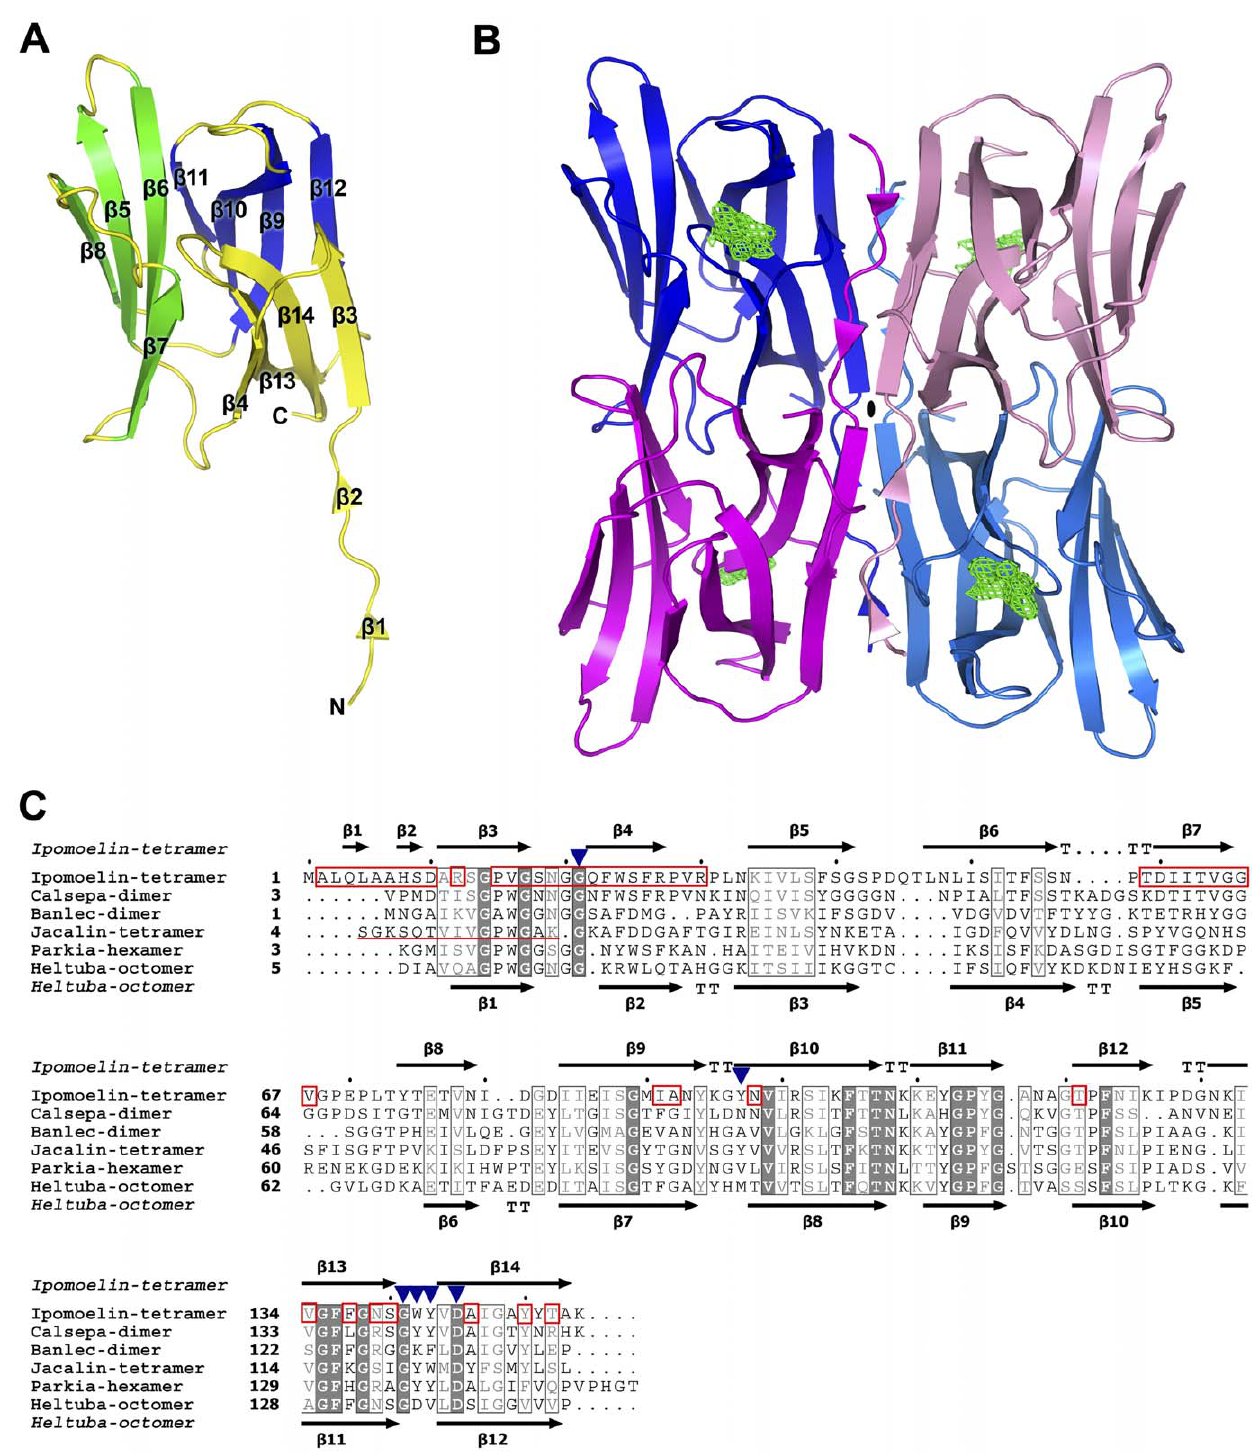
Figure 2. Ribbon diagram of IPO and sequence alignment of Jacalin-related lectins. ( A ) A ribbon diagram of monomeric IPO with 14 b - strands. ( B ) A ribbon diagram of a compact tetrameric IPO. The carbohydrate binding pockets are indicated by green mesh. Tetrameric IPO is represented by monomer A in blue, monomer B in purple, monomer C in light blue, and monomer D in pink. The symmetric axis is represented by a black ellipse in the center of tetramer. ( C ) Structure-based multiple sequence alignment of Jacalin family. Five homologs were selected for sequence comparison from resolved protein structures: Ipomoelin-tetramer from Ipomoea batatas (PDB: 3R52); Calsepa-dimer from Calystegia sepium (PDB: 1OUW); Banlec-dimer from Musa acuminate (PDB: 2BMZ); Jacalin-tetramer from Artocarpus hirsutus (PDB: 1TOQ); Parkia-hexamer from Parkia platycephala (PDB: 1ZGS); and Heltuba-octomer from Helianthus tuberosus (PDB: 1C3K). Positions of identical conserved residues are shown in white on dark grey background, and regions of similarly conserved residues in light grey are boxed. Representation of secondary structure elements and numbering above the alignment is based on the IPO structure. The secondary structure elements below the alignment are based on the Heltuba